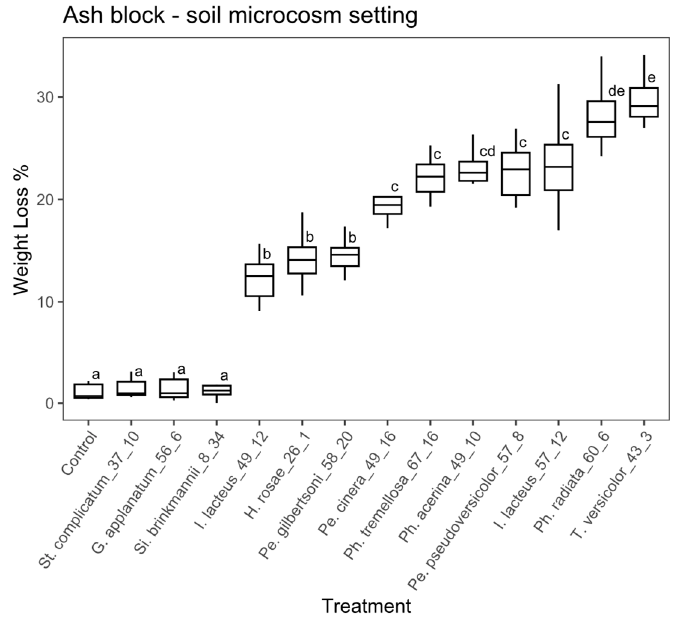
Figure 3. Boxplot of the percentage of weight loss for wooden blocks in the soil microcosm. Different letters represent statistical differences between treatments ( p < 0.01).